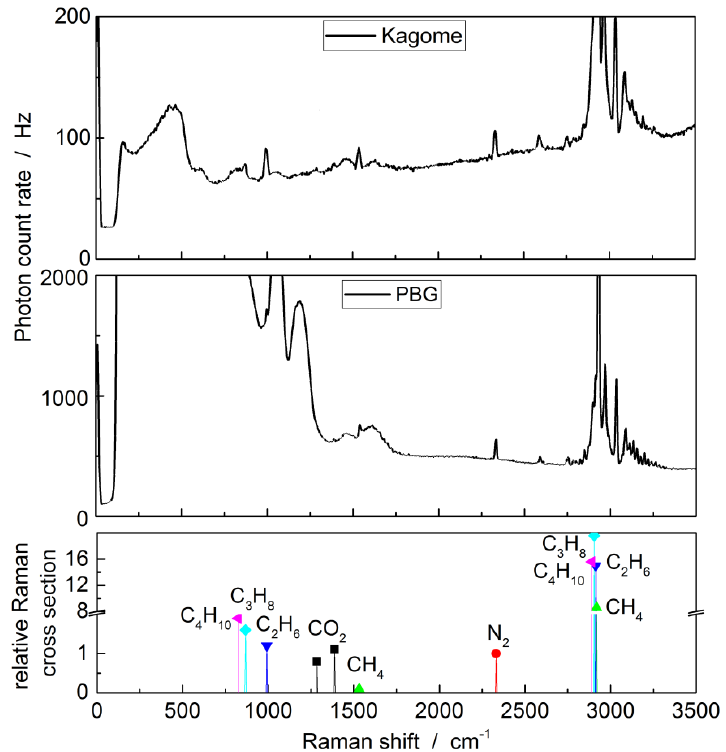
Figure 3. Spectra of the Raman scattering of natural gas for an input laser power of 27 mW. Displayed are scattered photons per second over the Raman shift in wavenumbers, i.e., inverse centimeters. Note the different vertical scales for the upper and middle panel. The large glass background for the PBG fiber can be seen from approximately 100 cm −1 to 1700 cm −1 . The lower panel displays the position of the different Raman peaks of the gas components. The relative Raman scattering cross-section for each molecule is normalized to that of nitrogen [37,75–77].